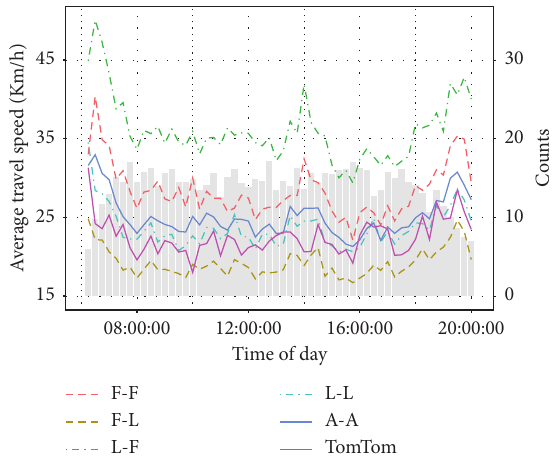
Figure 12: The comparison of five BTaverage speeds and TomTom average speed of link